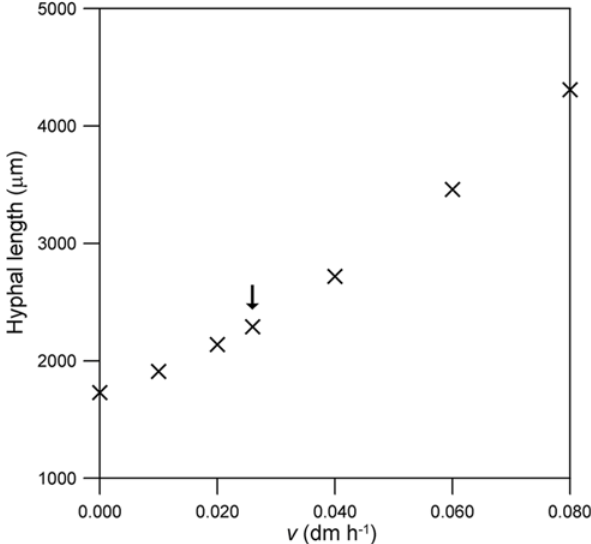
Fig 9. Effect of the convective flow velocity within the hypha ( v ). The comparison is based on the hyphal length reached at 24 h. The original value (i.e. that used for Figs. 3A and 4) is indicated with an arrow. The initial values of the variables and the other parameter values are as listed for Rhizopus oligosporus in Table